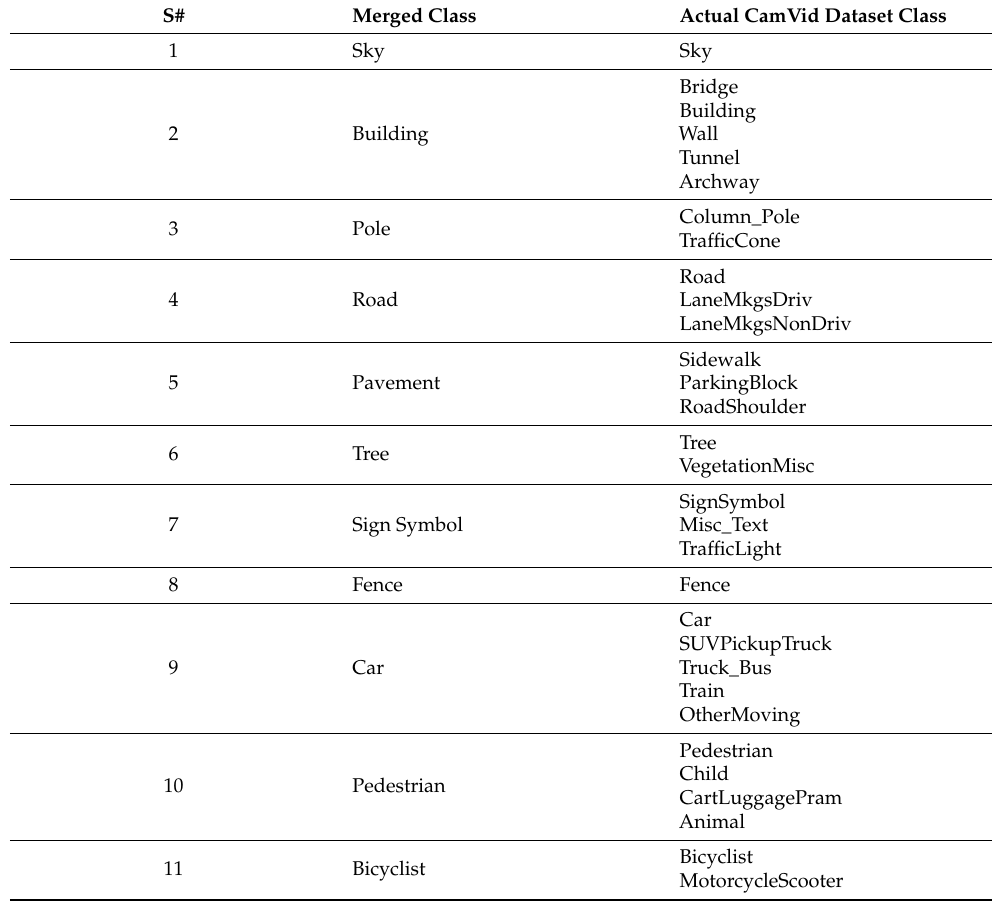
Table 2. Actual CamVid Classes vs. Merged